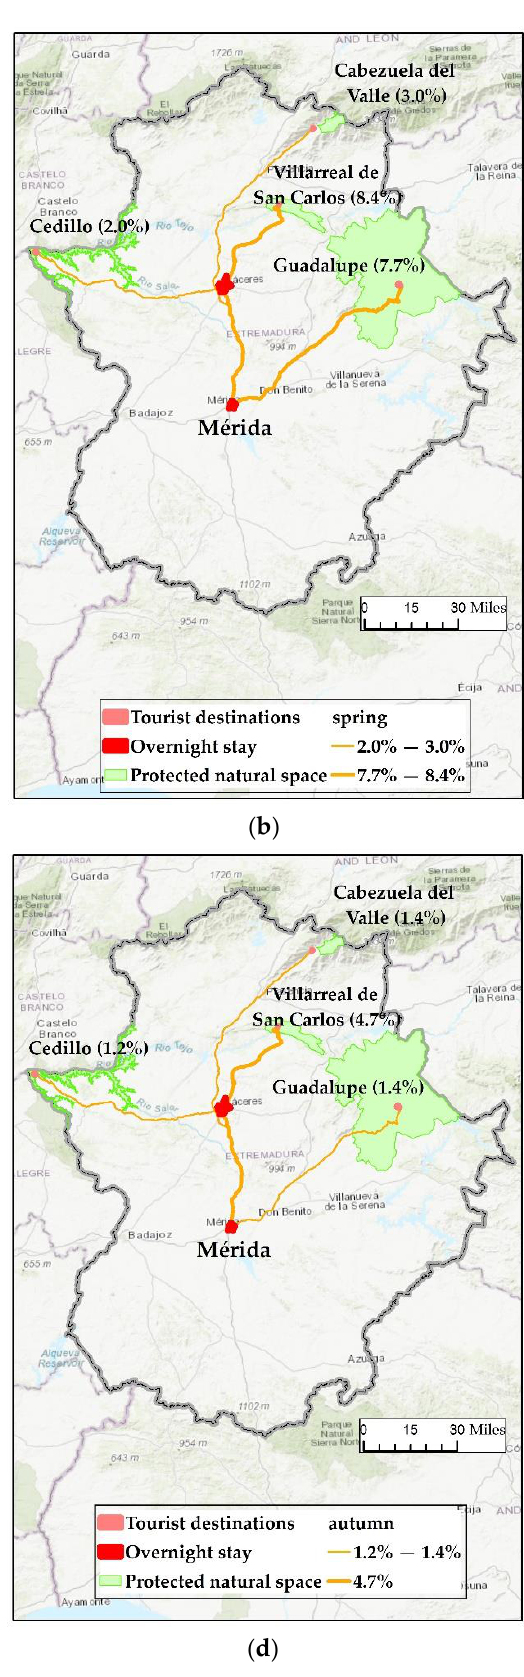
Table 5. Annual average Monfragüe Nat. Park